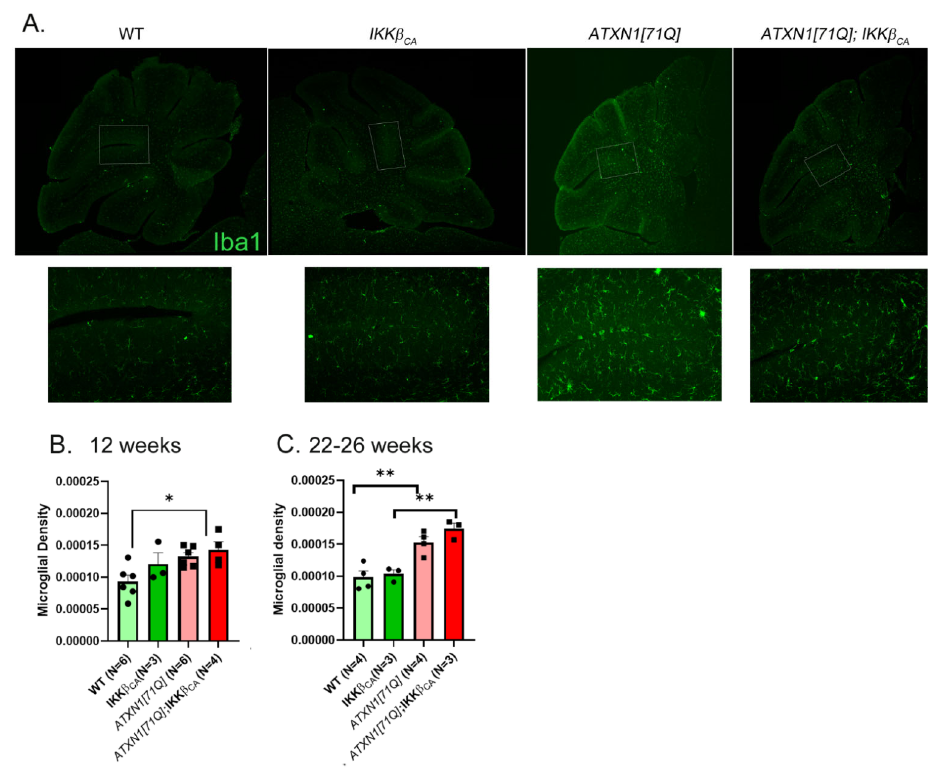
Figure 7. Increased microglia density in cerebella of ATXN1[71Q] mice . Representative Iba1 immunofluorescence staining of the whole cerebella of 12 ‐ week ‐ old mice. Boxed regions of the molecular layer are shown below. ( A ) Scale bar = 100 μ m. Image J was used to quantify the density of Iba1 ‐ positive microglia at 12 weeks ( B ) and 22–26 weeks ( C ). Data are presented as mean ± SEM with average values for each mouse represented by a dot. * p < 0.05, ** p < 0.005 using one ‐ way ANOVA with Bonferroni’s multiple comparison test. Error bars = S.E.M.